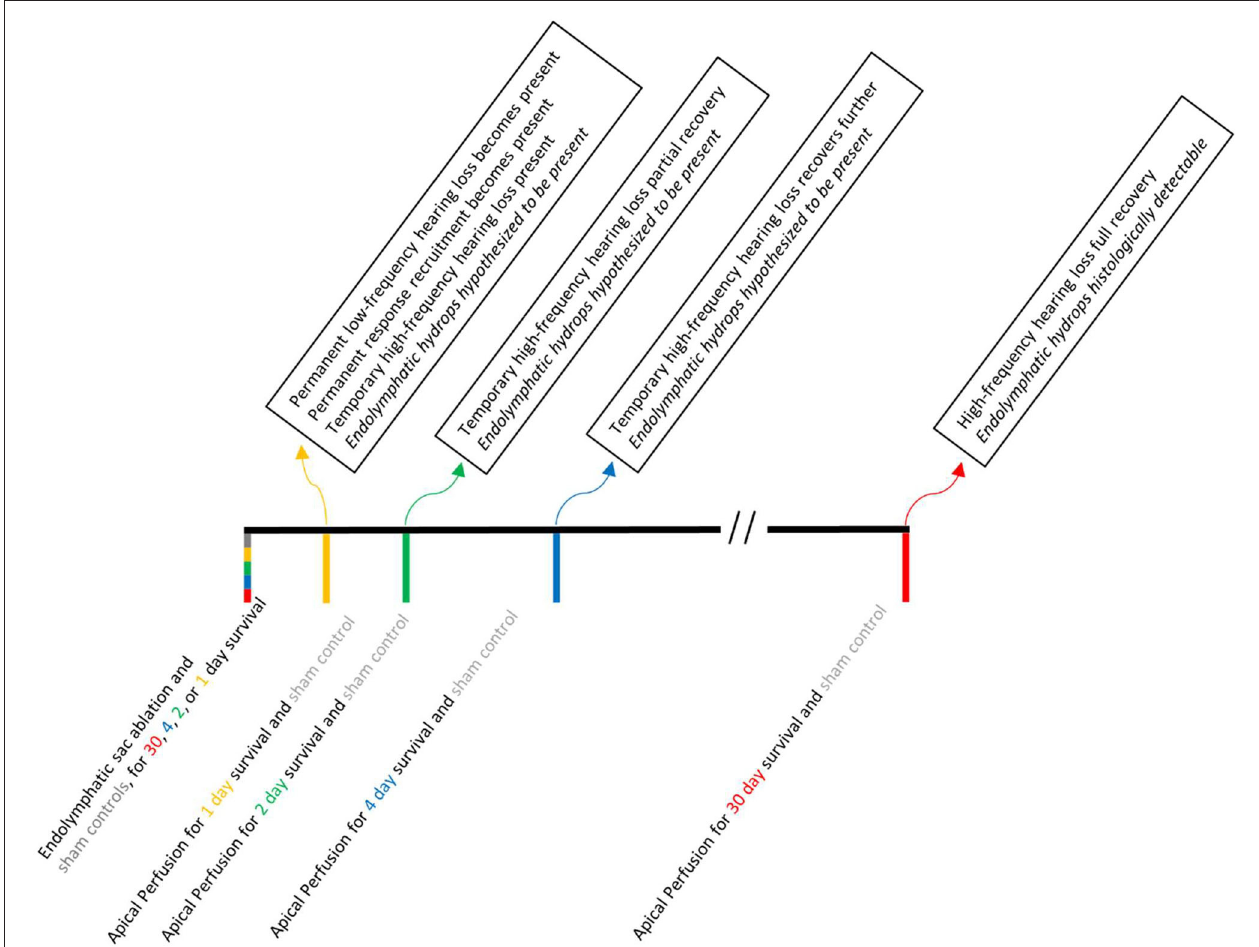
FIGURE 1 | A time line of the experimental manipulations (below the line) and results (above the line) associated with endolymphatic sac ablation. Acute apical perfusion of HPBCD in otherwise naïve ears are not shown because all of the experimental manipulations and testing were done on the same